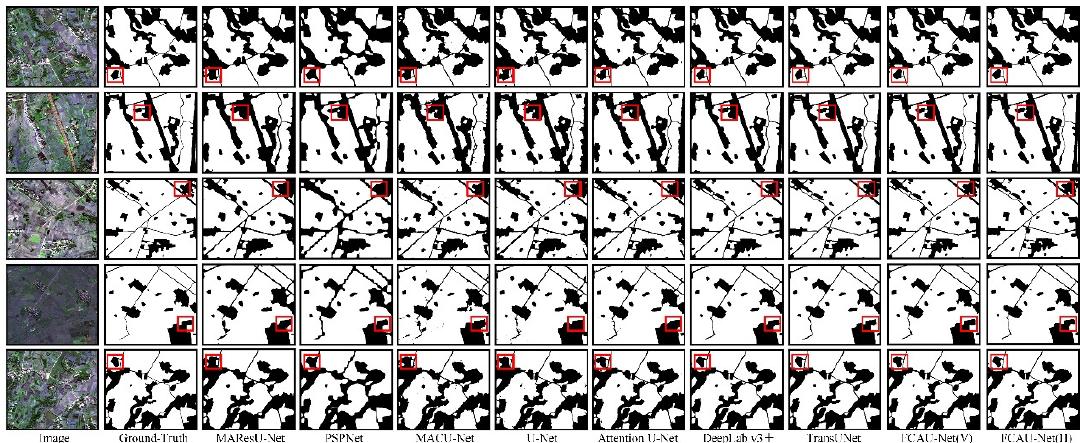
Figure 10. The experimental results obtained on the ZY-3 dataset.